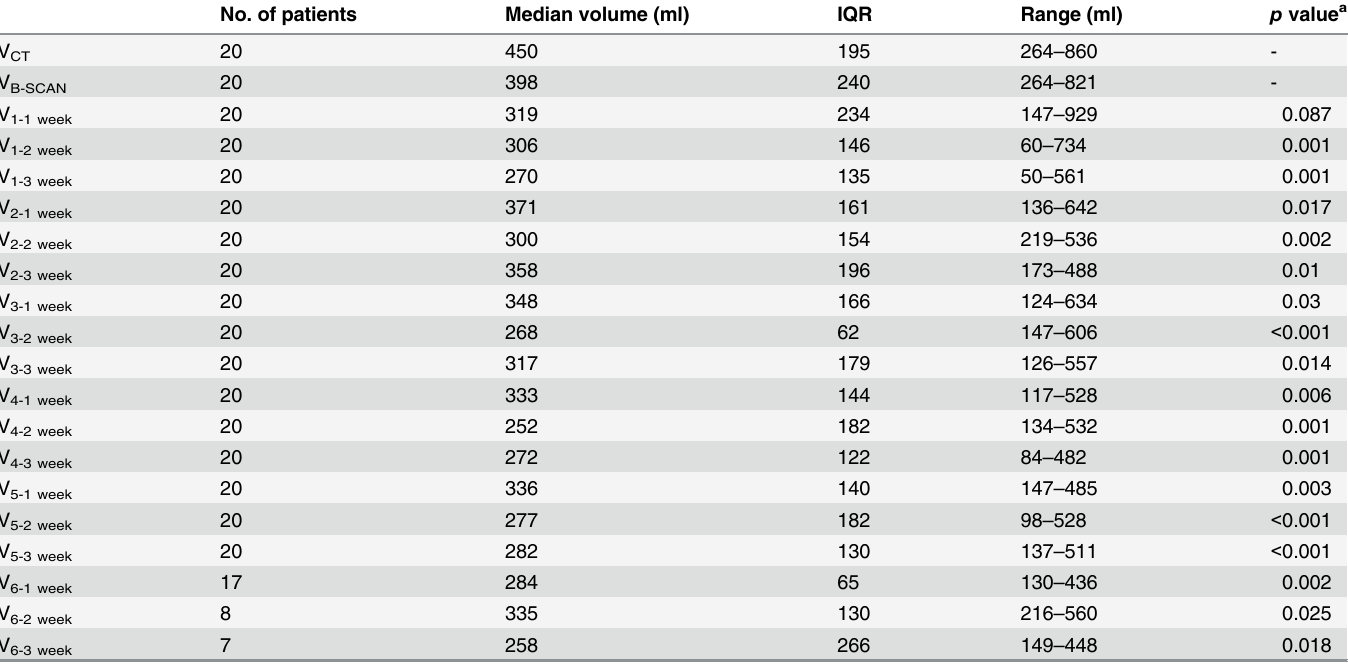
Table 4. Time trends of bladder volume from CT scans and bladder